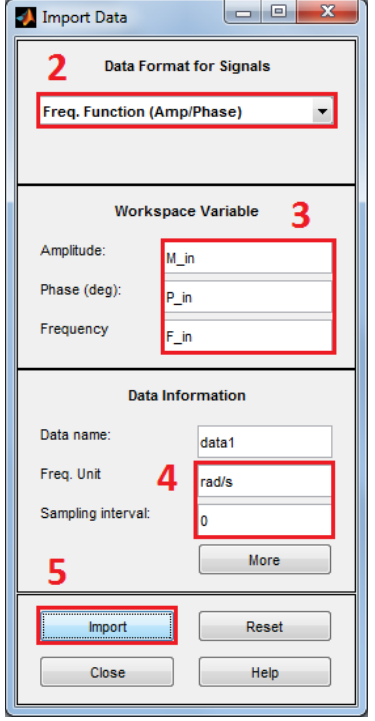
Figure 10: System identification toolbox layout part